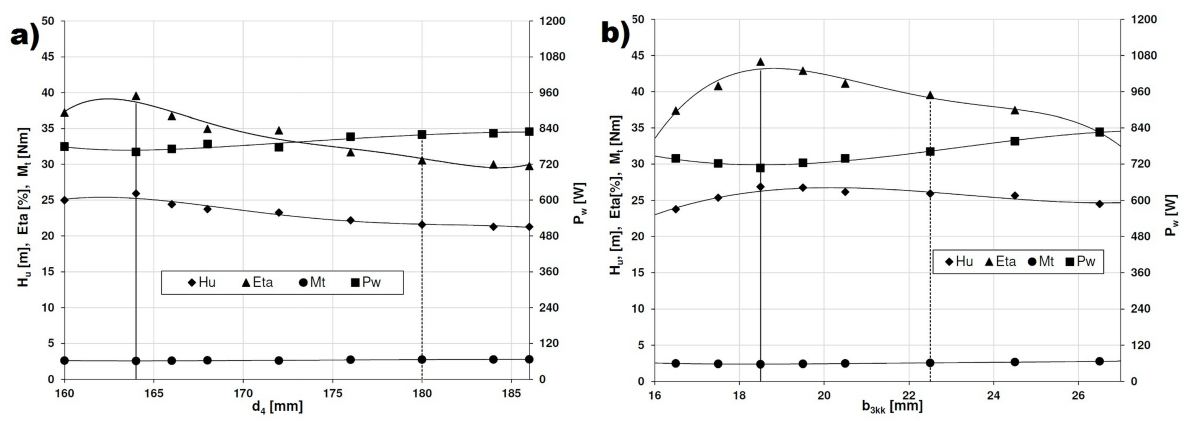
Figure 10: Influence of alteration of the diameter d 4 (a) and width b 3 kk (b) of the annular casing